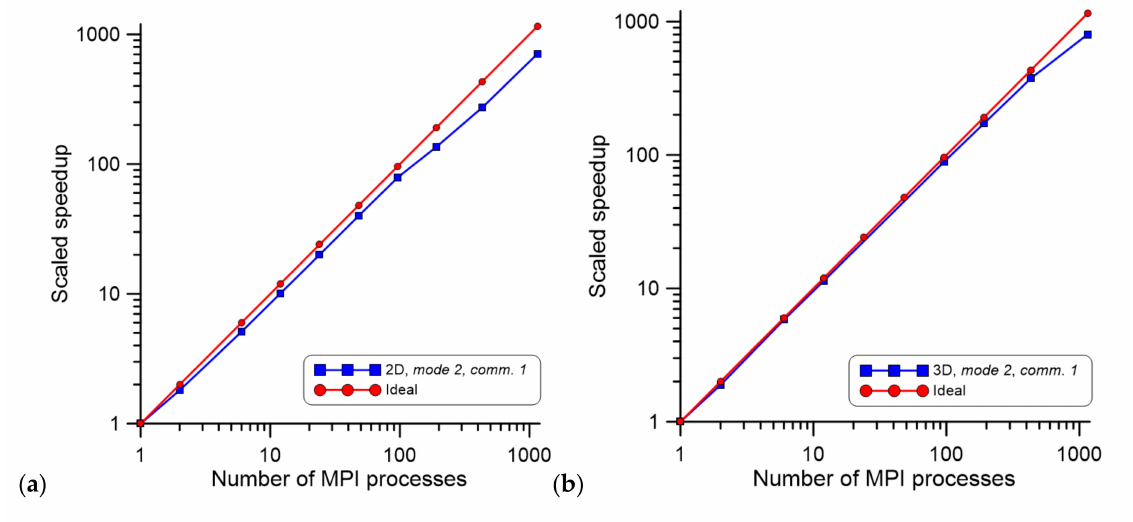
Figure 8. Scaled speedup for ( a ) 2D and ( b ) 3D investigations with an increasing number of MPI processes and a growing CA space